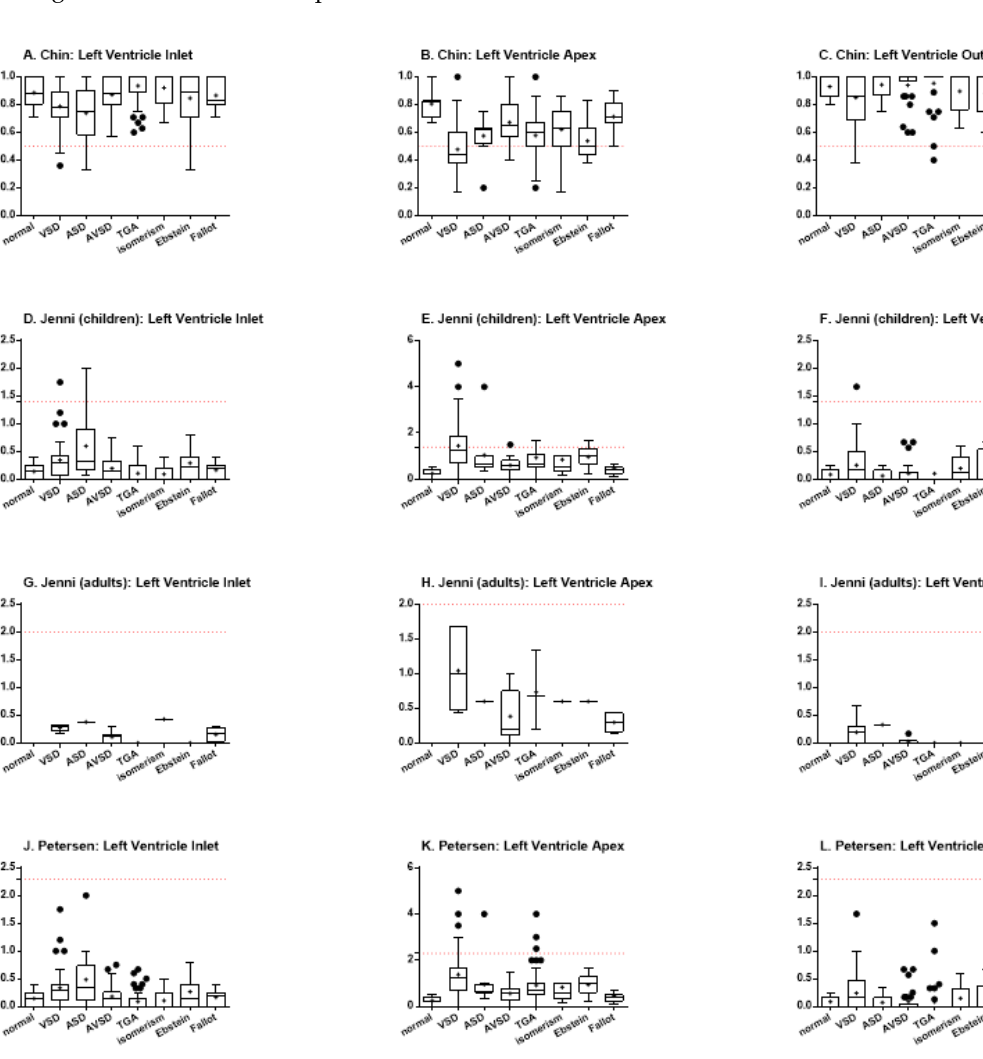
Figure 3. Indexes of ventricular trabeculation, as evaluated by Chin, Jenni, and Petersen methods, in the inlet, apex and outlet muscular walls of the left ventricle. The red dotted lines represent the threshold for LVNC for each criterium.( A ) Chin, left ventricle inlet; ( B ) Chin, left ventricle apex; ( C ) Chin, left ventricle outlet; ( D ) Jenni, (children) left ventricle inlet; ( E ) Jenni, (children) left ventricle apex; ( F ) Jenni, (children) left ventricle outlet; ( G ) Jenni, (adults) left ventricle inlet; ( H ) Jenni, (adults) left ventricle apex; ( I ) Jenni, (adults) left ventricle outlet; ( J ) Petersen, left ventricle inlet; ( K ) Petersen, left ventricle apex; ( L ) Petersen, left ventricle outlet.